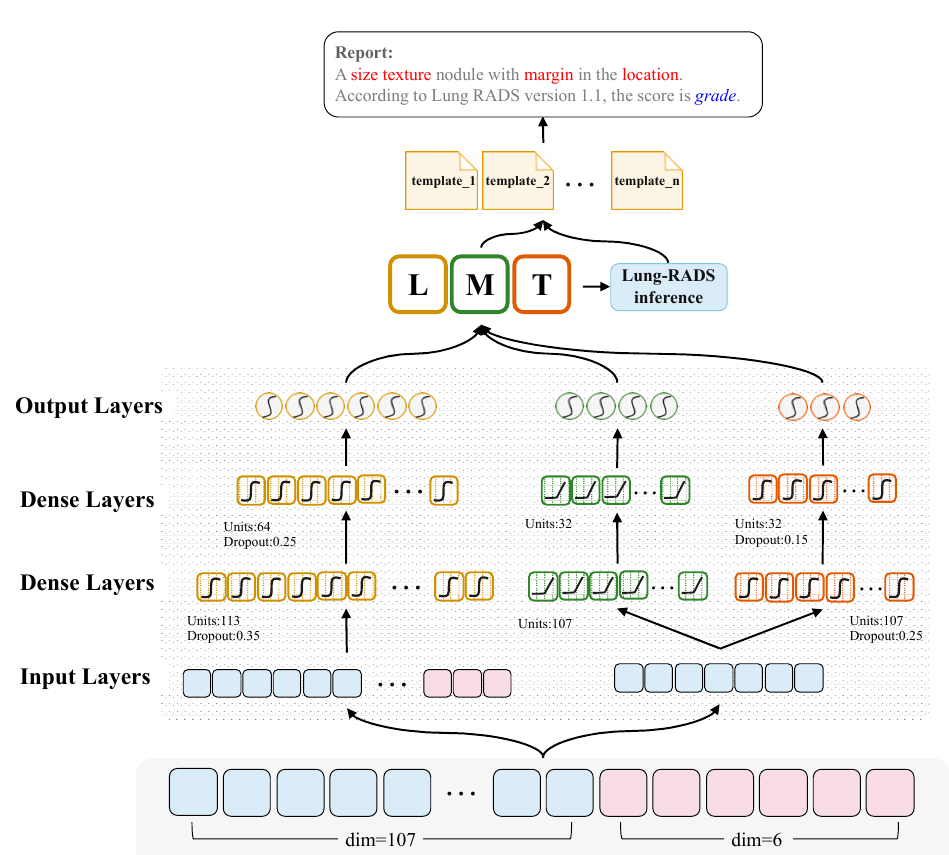
Figure 1. Illustration of the proposed multi-objective deep learning framework for semantic feature prediction. For prediction of the final targets: location (L), margin (M), and texture (T), the input layer of the proposed model is a multi-feature fusion vector that integrates 107-dimensional radiomics feature with 6 extra SISN features extracted from the information of nodule segmentation. Afterwards, there are two dense layers with dropout. The activation of the last two dense and the output layer are different, wherein ReLU is used for predicting Margin and tanh is used for Location and Texture. The final activation function of the output layer to predict results is softmax. Using the prediction results of these three semantic features, the radiology reports can be generated through filling slots of a set of predefined templates.